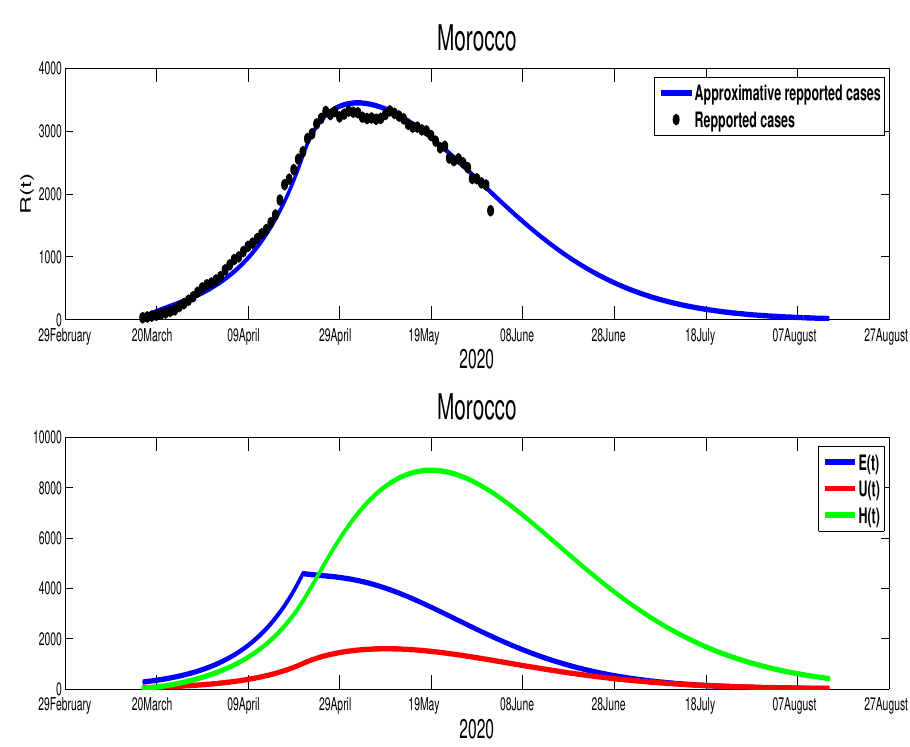
Figure 6. The predictive results for